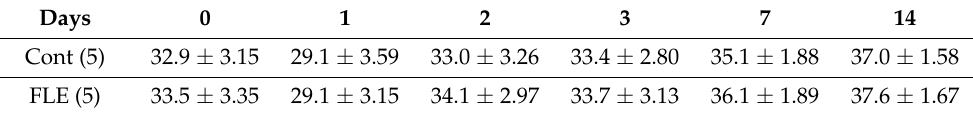
Table 13. Influence of a single oral dose of FLE (6.67 g/kg/day) to male ddYmice on body weight. Days